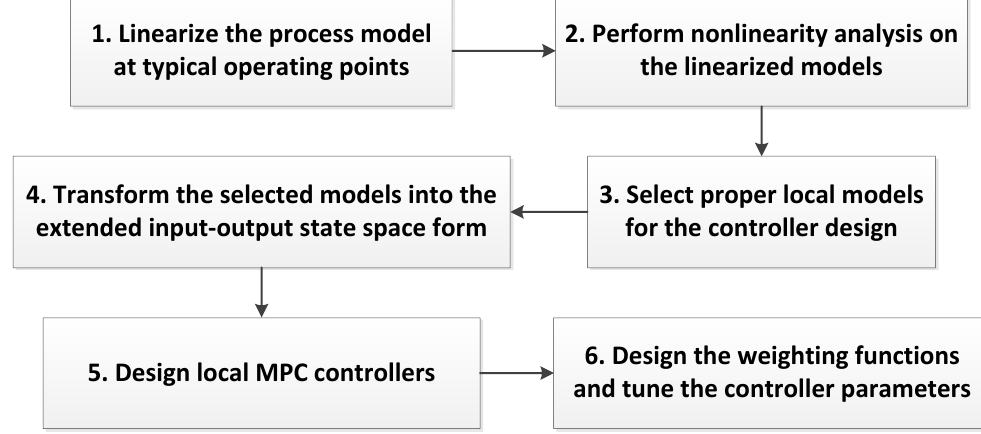
 = dotted line.  = solid line, 2 1